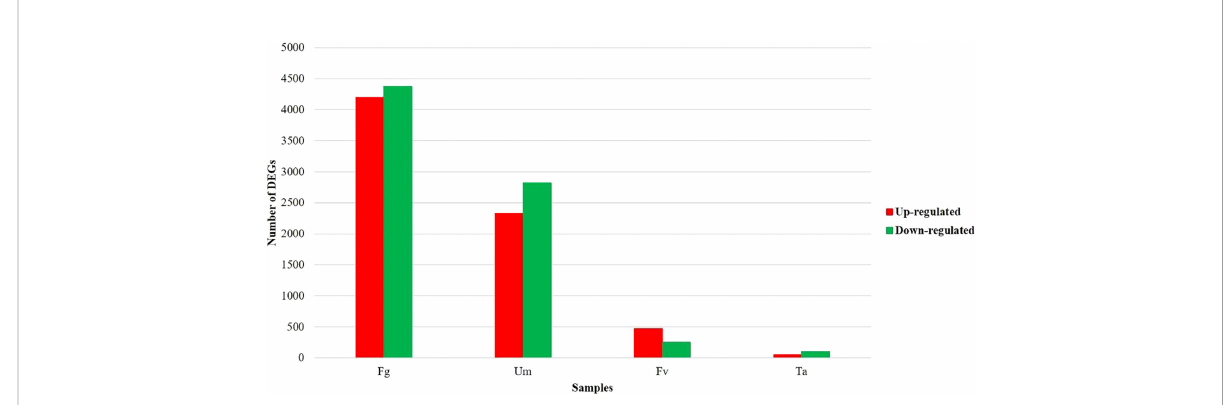
FIGURE 1 Distribution of differentially expressed genes involved in multiple fungal infections in silk of Z. mays . Fg, F. graminearum ; Um, U. maydis ; Fv, F. verticillioides ; Ta, T.